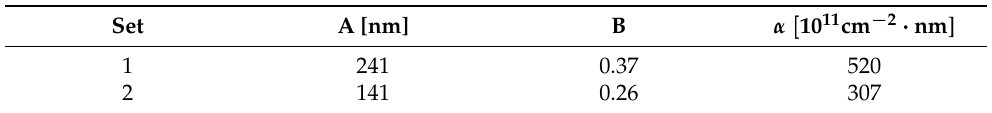
Table 1. Fit results for the data reported in Figure 1b in the main text. α is the value of A transposed in the density of defects by Equation